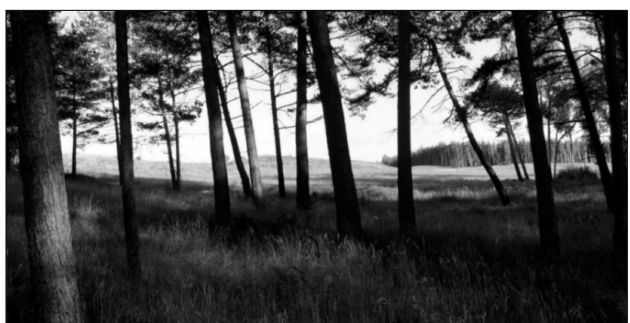
Figure 8. Mature Scots pine wood with dry grasslands in the background (photo by Arvydas Urbis).